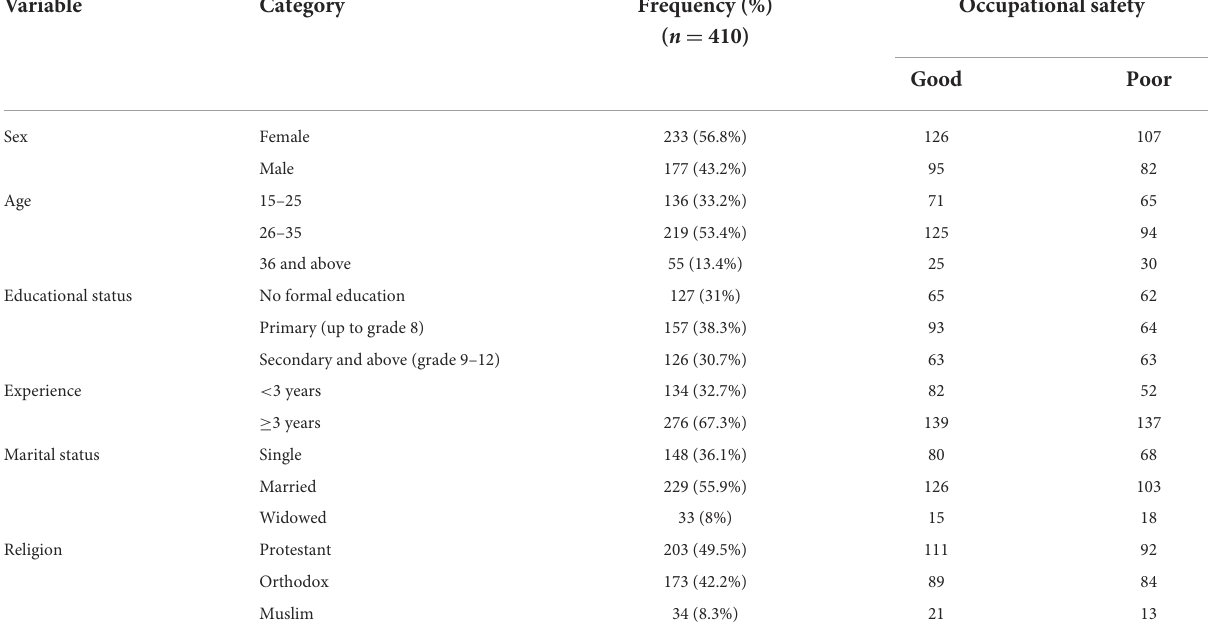
TABLE 1 Sociodemographic characteristics of the Bule Hora University janitors in Southern Ethiopia from November to December 2021.